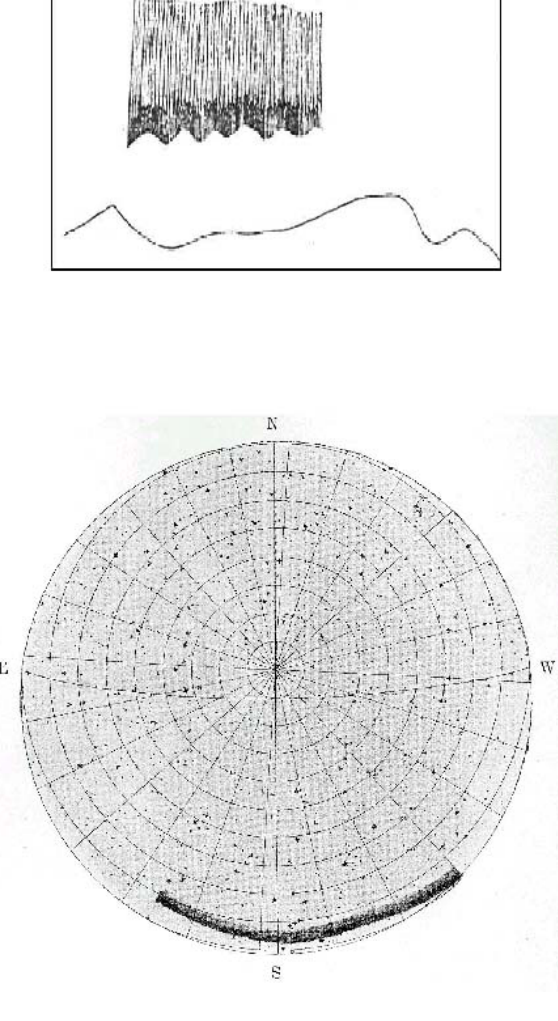
Fig. 18. All-sky drawing of aurora at Treurenberg Bay and sketch of aurora at Konstantinovka on 28 January 1900 at 08:06